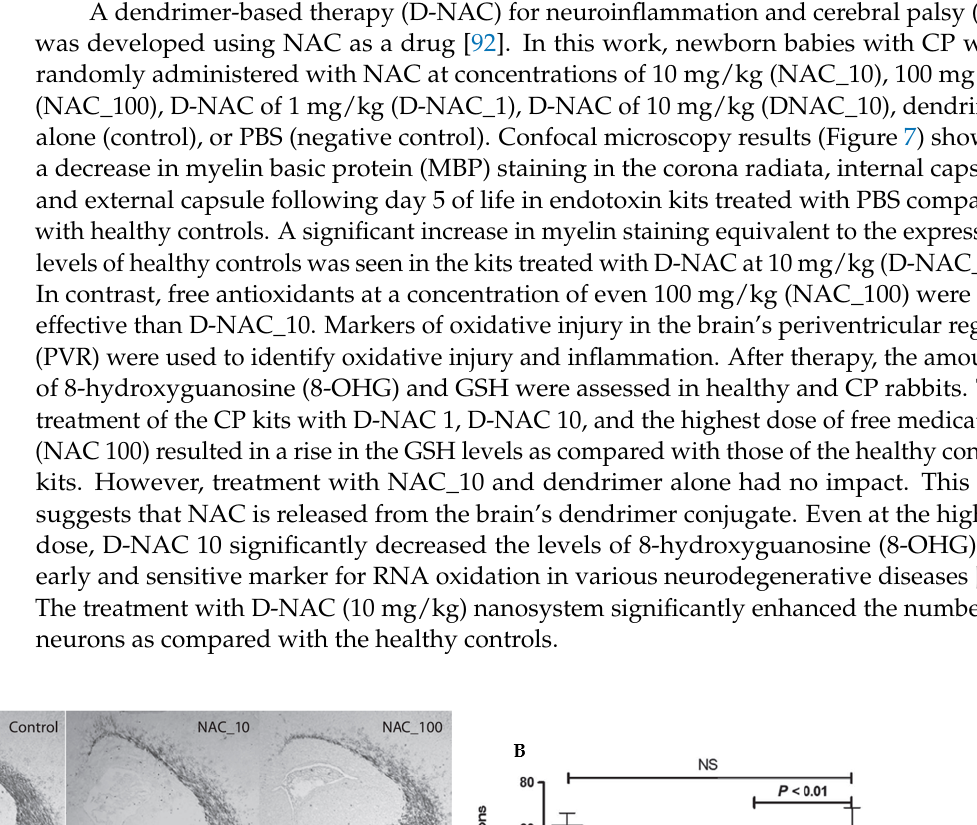
Figure 7. Effects of a NAC-based nanosystem on myelination and neuronal injury in a dendrimer- based therapy (D-NAC) against neuroinflammation and cerebral palsy (CP). ( A ) Confocal micros- copy results were obtained with brain sections harvested and stained for myelin basic protein (MBP) using DAB staining. The images show a decrease in the MBP staining in the corona radiata, internal capsule, and external capsule following day 5 of life in endotoxin kits treated with PBS compared with healthy controls. ( B ) Microtubule-associated protein 2 (MAP2) labeling was used